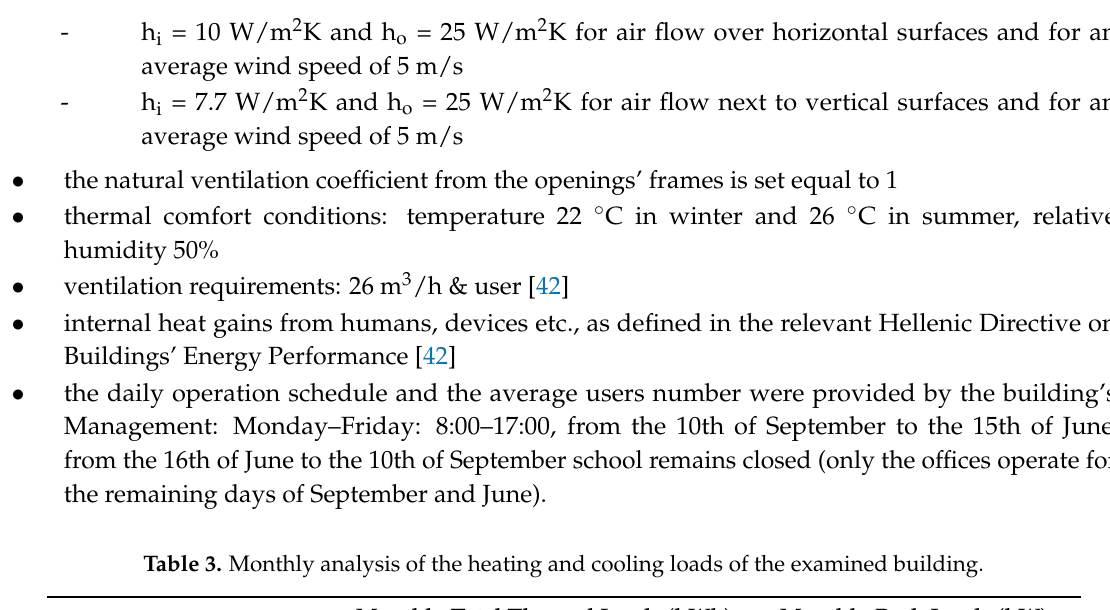
Table 3. Monthly analysis of the heating and cooling loads of the examined building. Monthly Total Thermal Loads (kWh) Monthly Peak Loads (kW) Months Heating Cooling Heating Cooling January